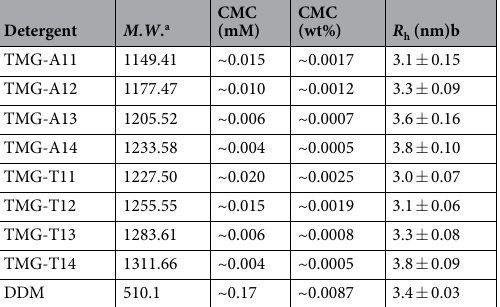
Table 1. Molecular weights and critical micelle concentrations (CMCs) of TMGs (TMG-As/Ts) and a conventional detergent (DDM) and hydrodynamic radii ( R h ; n = 5) of their micelles measured in pure water. a Molecular weight of amphiphiles. b Hydrodynamic radius of detergent micelles determined at 1.0 wt% by dynamic light